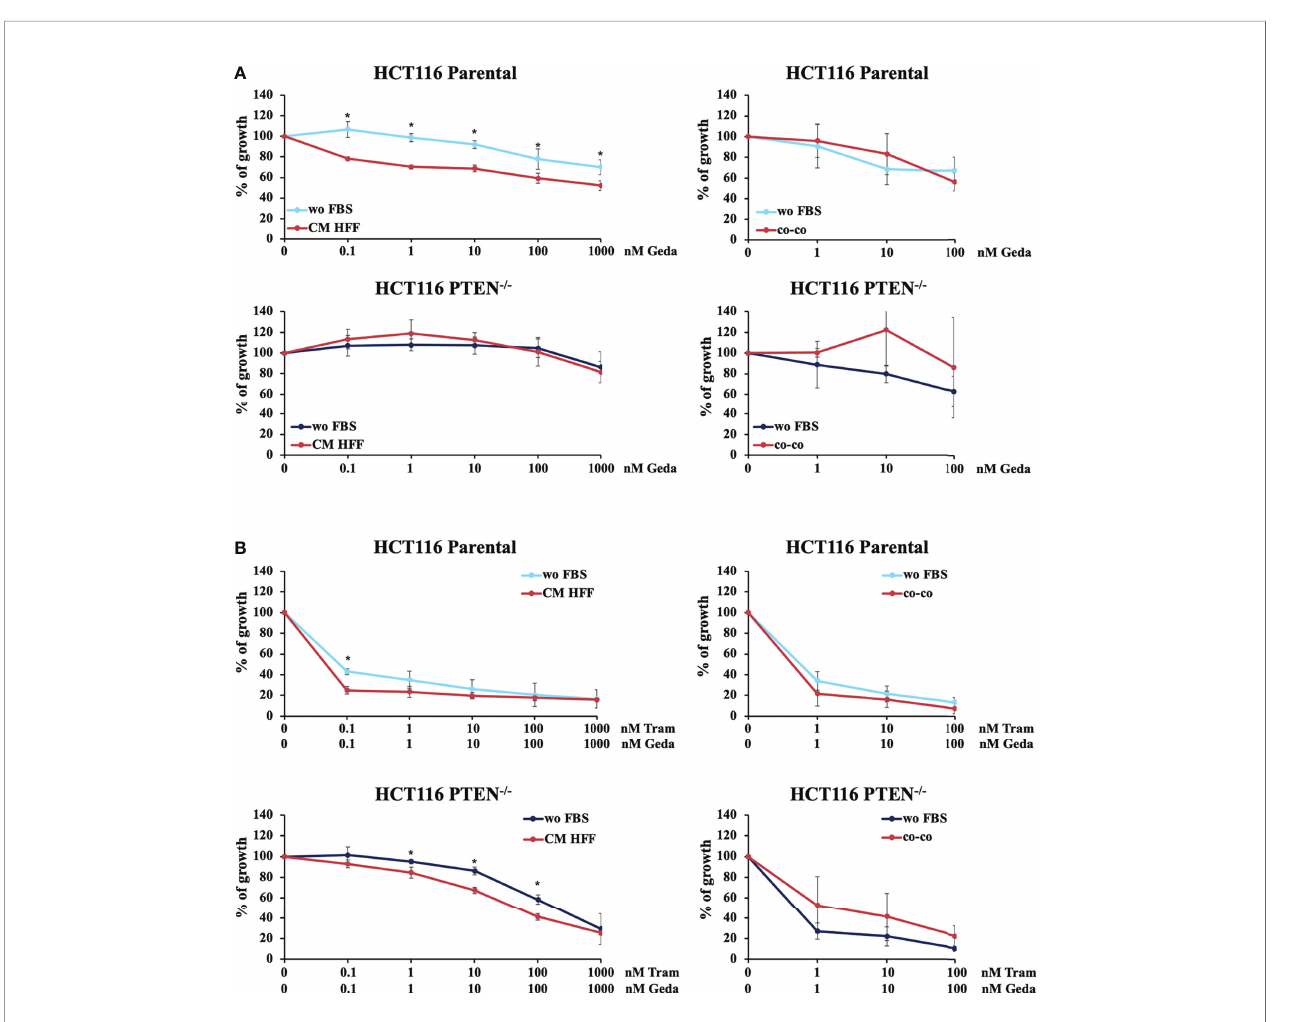
FIGURE 1 | PTEN expression and microenvironmental interactions affect the response to molecular targeted inhibition in isogenic CRC cell lines. HCT116 Parental and HCT116 PTEN -/- cell lines were treated with increased doses (dose range 0.1-1000 nM) of Geda or Geda and Tram combination (1:1) ( A , B , respectively) in serum-free condition, fi broblast HFF derived CM (left panels) or direct CRC/GFP-tagged HFF co-culture (right panels). Cell viability for wo FBS and HFF-CM was assessed by Crystal Violet assay after 72 h of treatment. For HFF co-culture cells were counted after 72 h of treatment and the number of GFP positive and negative cells were calculated using cyto fl uorimetric analysis. Results are expressed as percentage of growth inhibition relative to untreated control and represent the average ± SEM of three independent experiments. Asterisks indicate statistically signi fi cant differences (p-value < 0.05 by 2-tailed Student ’ s t test) for the comparison between treatment under wo FBS and HFF-CM or co-co conditions.